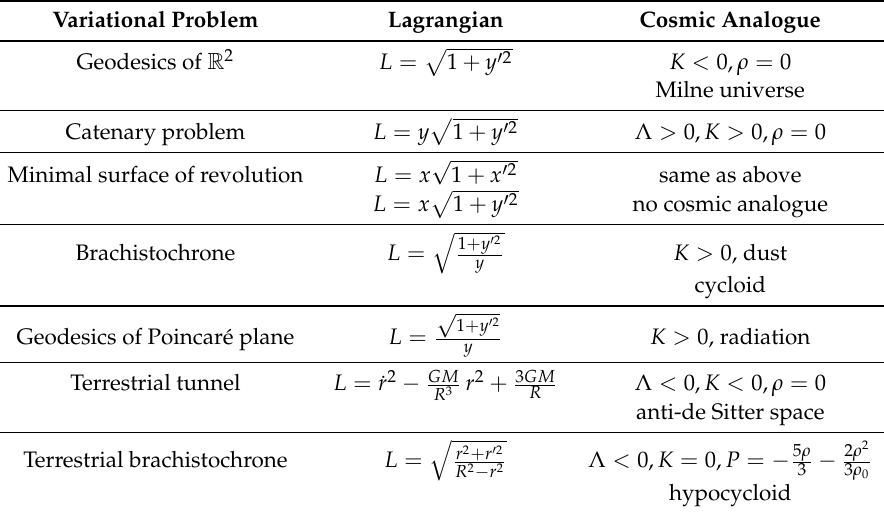
Table 1. Cosmic analogues of variational